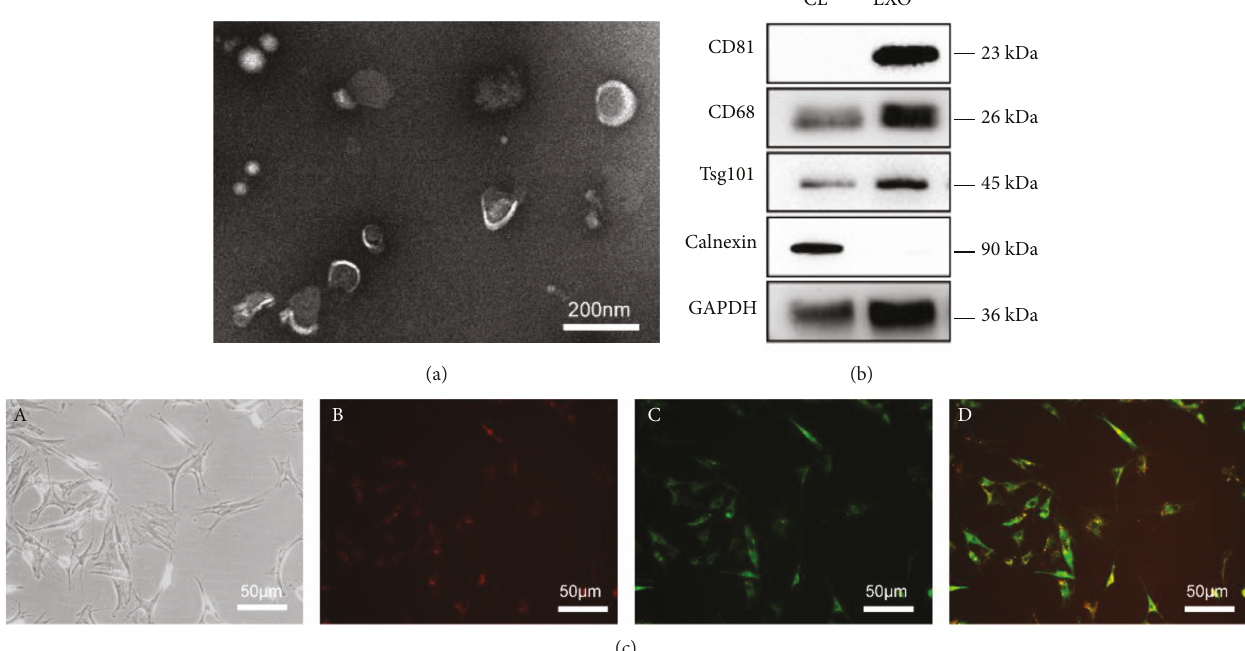
Figure 2: Identi fi cation of NPC exosomes and internalization of NPC exosomes by MSCs. (a) Characteristics of exosomes derived from NPCs under a transmission electron microscope. (b) Western blot analyses of exosomal protein markers CD63, CD81, and Tsg101 and negative protein calnexin. CL: NPC cell lysate; EXO: NPC exosomes. (c, A) Internalization of NPC exosomes by MSCs. NPC exosomes were stained with CM-Dil (B), and MSCs were stained with CM-Dio (C). Internalization was observed by a fl uorescence microscope